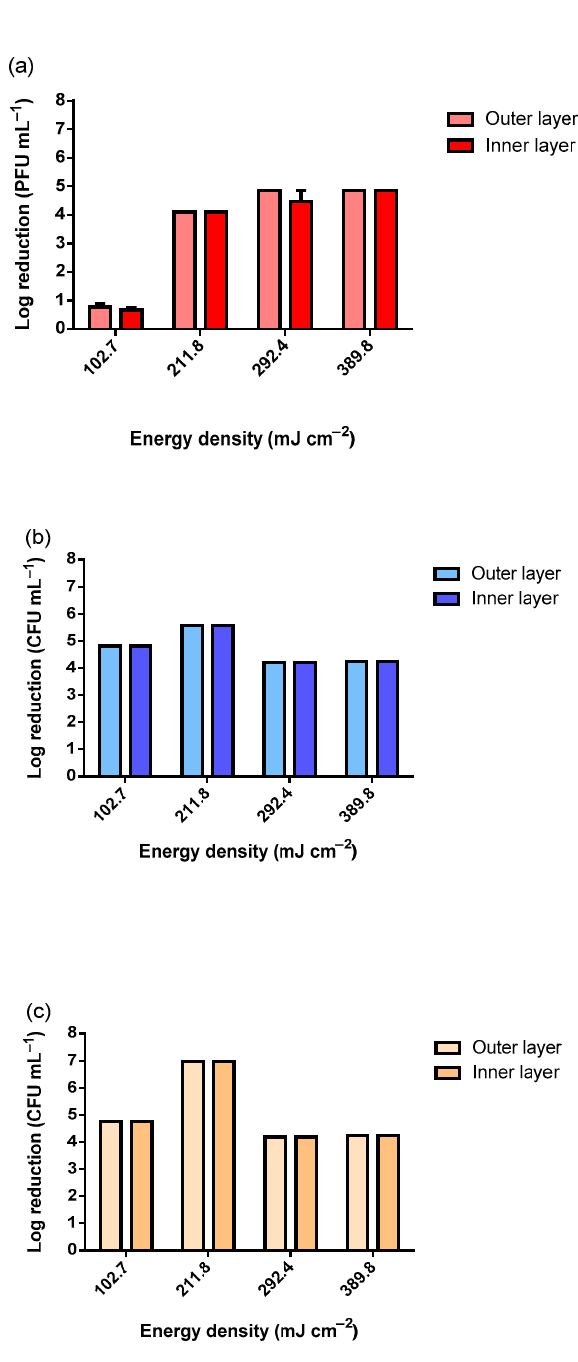
Figure 3. Viability reduction in ( a ) MS2 bacteriophage (inoculum titer: 1 × 10 7 PFU mL − 1 ), ( b ) S. aureus and ( c ) E. coli (inocula concentration: 1 × 10 7 CFU mL − 1 ) according to the different UV-C dosages using a 75 W UV-C